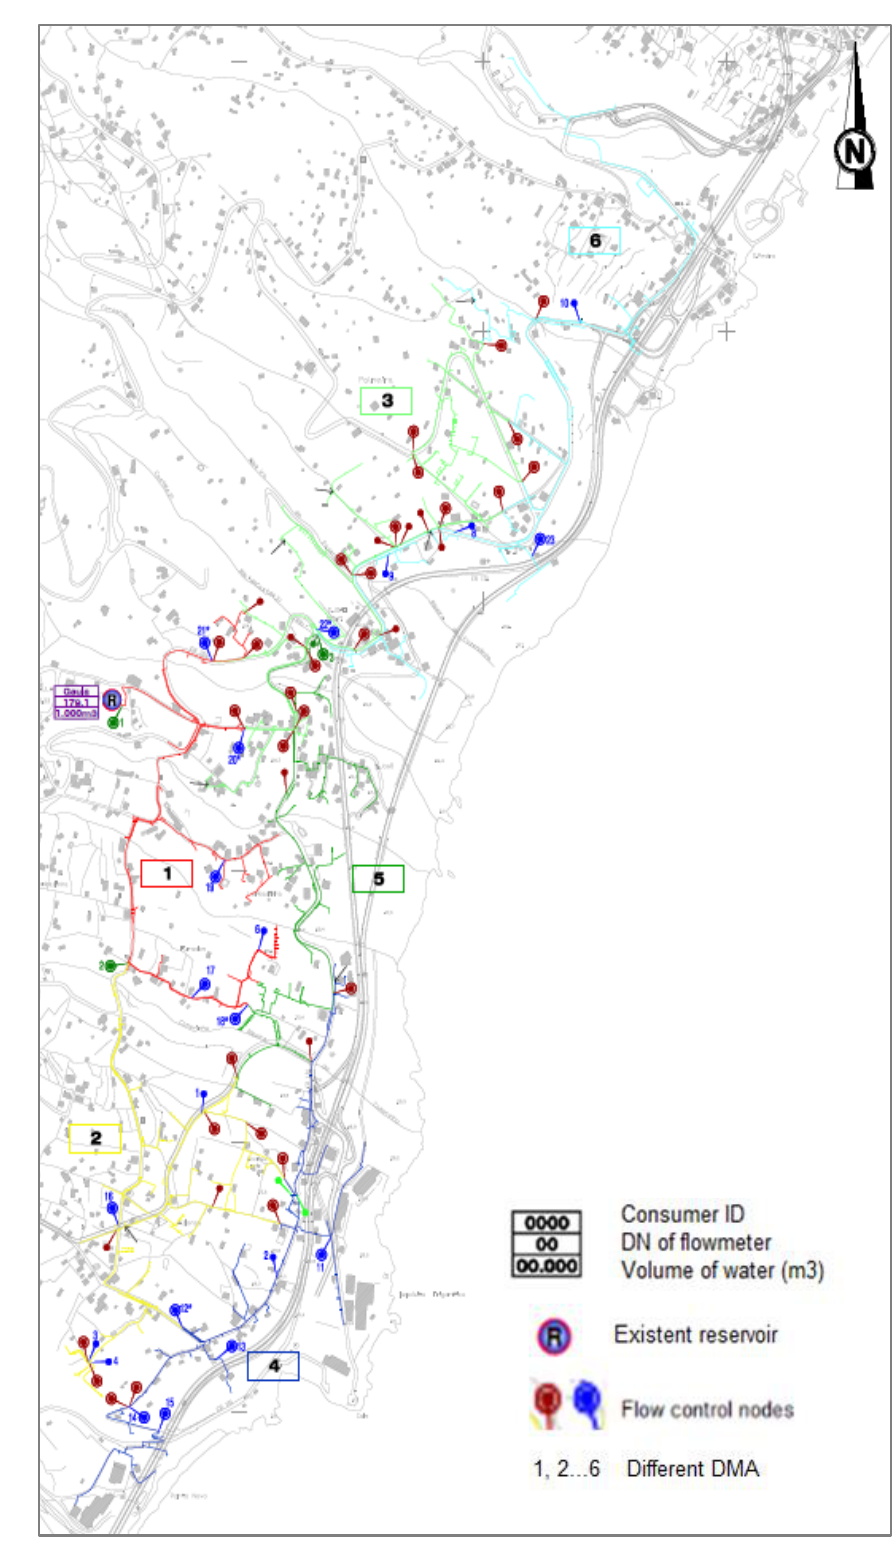
Figure 10. DMA sectorization of the Gaula WDN.